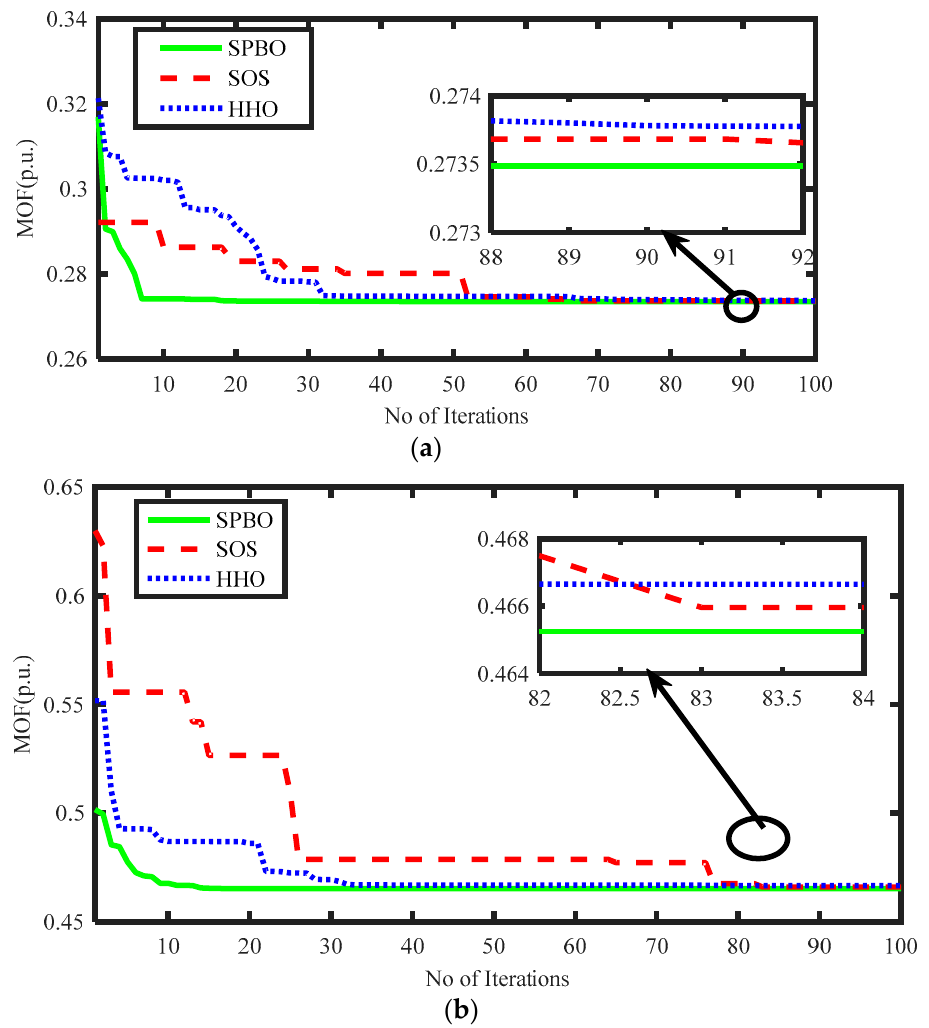
Figure 4. CC of optimization algorithms for case-3. ( a ) 33-bus test system; ( b ) 118-bus test system.